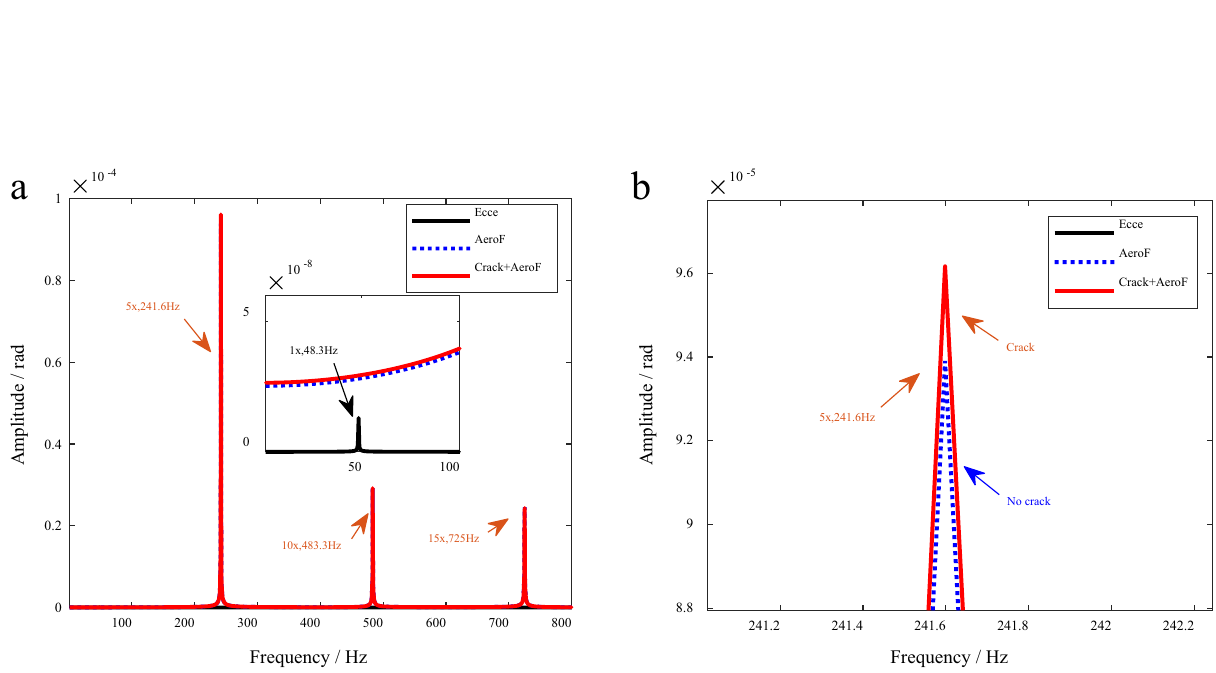
Figure 7. Spectrums of torsional vibration response. ( N s = N d = 5). ( a ) AeroF. ( b ) Crack +